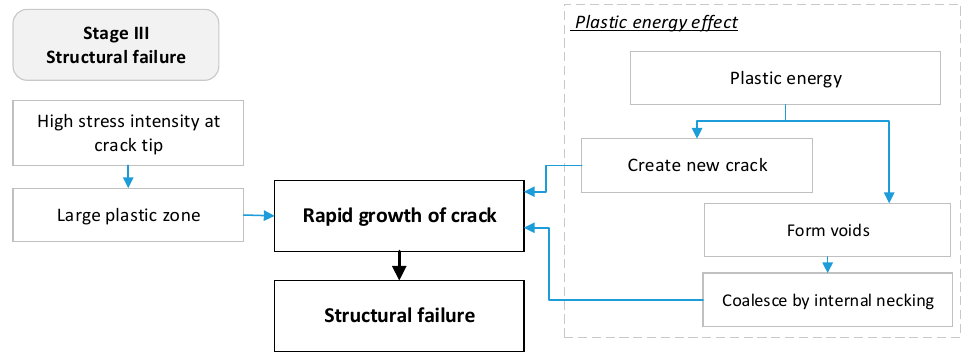
Figure 21. Key elements in the stage of structural failure.